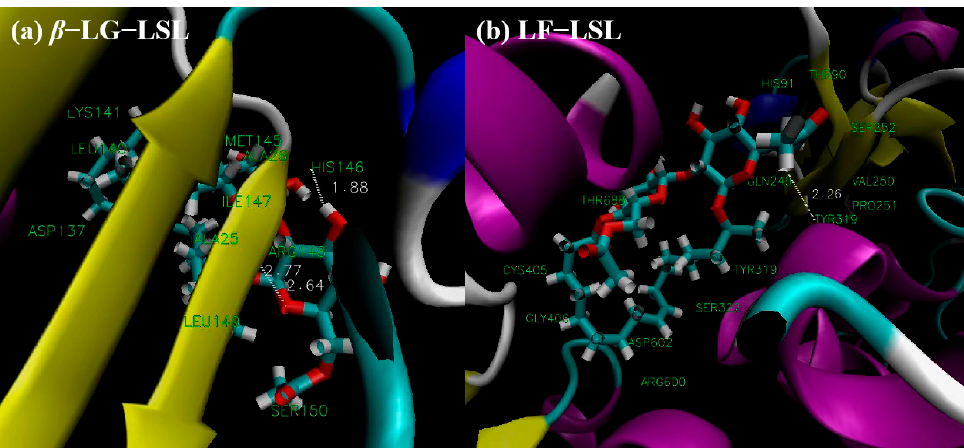
Figure 6. The putative LSL binding sites with β − LG ( a ) or LF ( b ) in 3D molecular docking